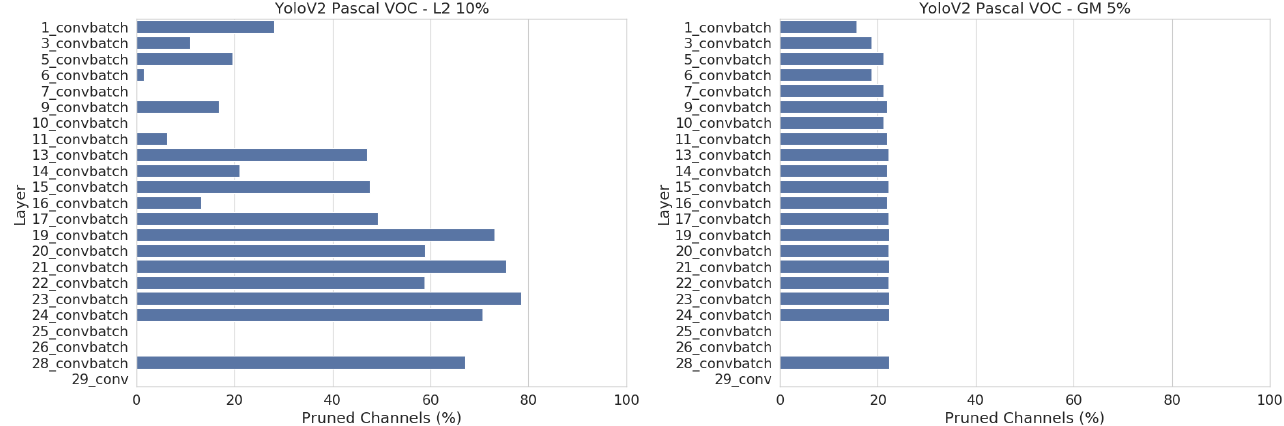
Figure 9. Number of discarded channels per layer after pruning YoloV2 with L2 ( left ) and GM ( right ). The best pruned version of each are shown. These plots show the disadvantage of GM pruning, which can only prune all layers uniformly and thus gets a lower overall pruning